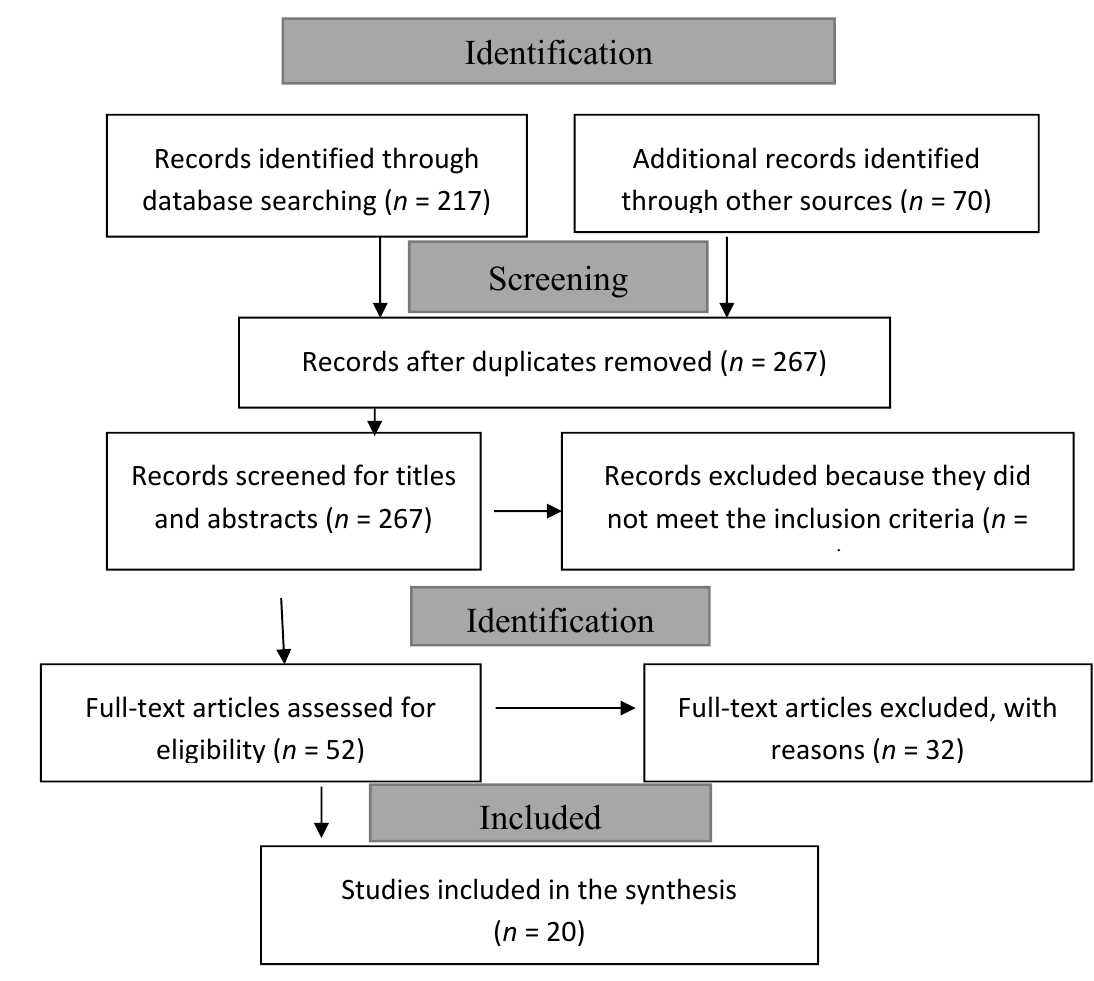
Figure 1. Flowchart showing the inclusion process.